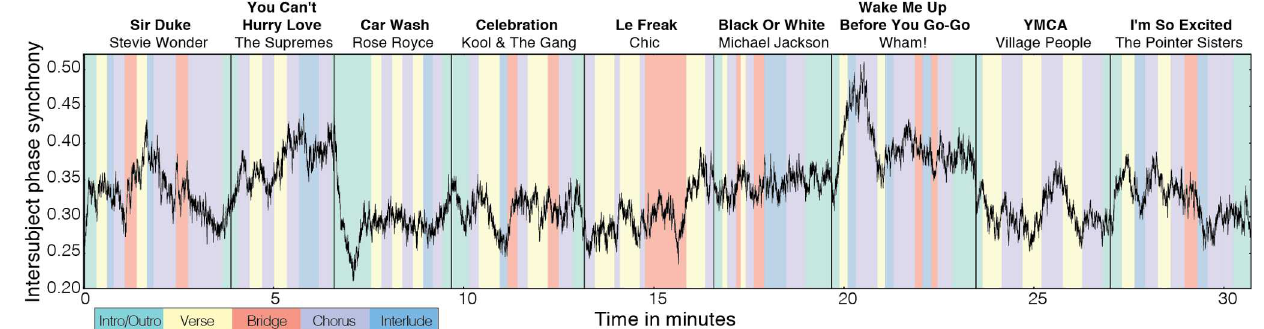
Fig 1. Group synchrony of movement over time during a music set at a dance club. Movement data from participants at the event were preprocessed and analyzedusing z -alignedaxis combination, linear interpolation, averagingdownsampling, coif1 wavelet decomposition, and intersubject phase synchronization. The group movement synchrony time course is divided into the songs played during the music set and segmented into the different parts of a song, includingintro and outro, verse, pre-chorus and bridge, chorus, and